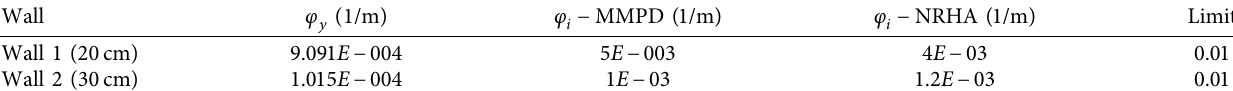
� 0.887) and NRHA M